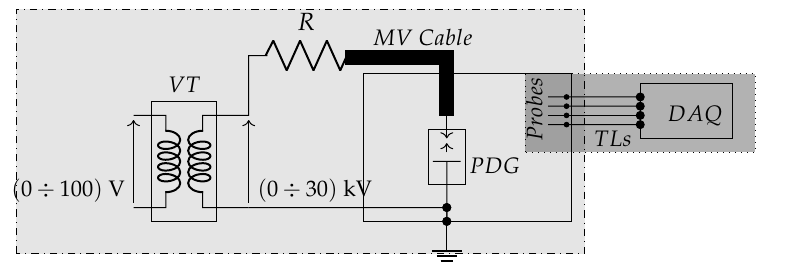
Figure 1. Experimental setup. VT: Voltage Transformer; R: Resistor; PDG: Partial Discharge Generator; TLs: Transmission Lines; DAQ: Data AcQuisition. Dash-dotted rectangle (light gray): PD generation. Dotted rectangle (darker gray): PD detection.